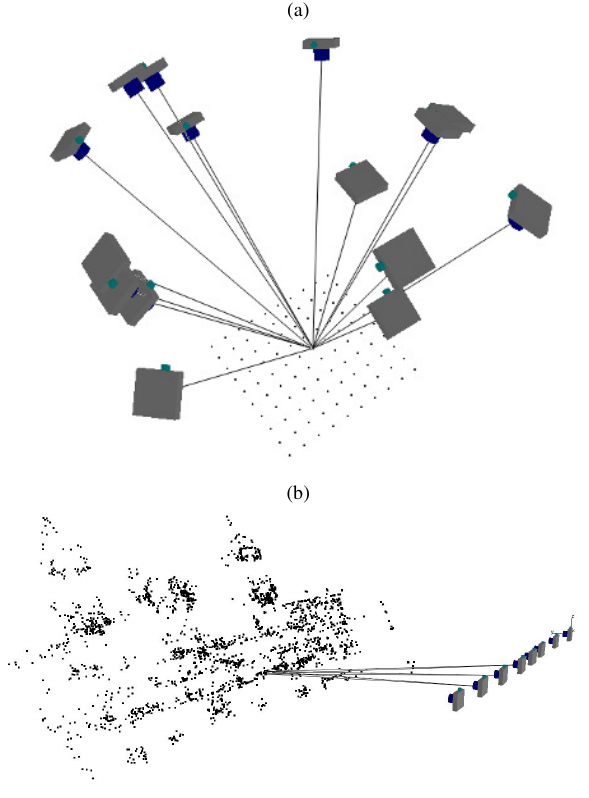
Figure 2. An appropriate image network which allows the correct estimation of all calibration parameters (a). An image network inappropriate for camera calibration and more efficient for scene reconstruction and 3D modeling applications